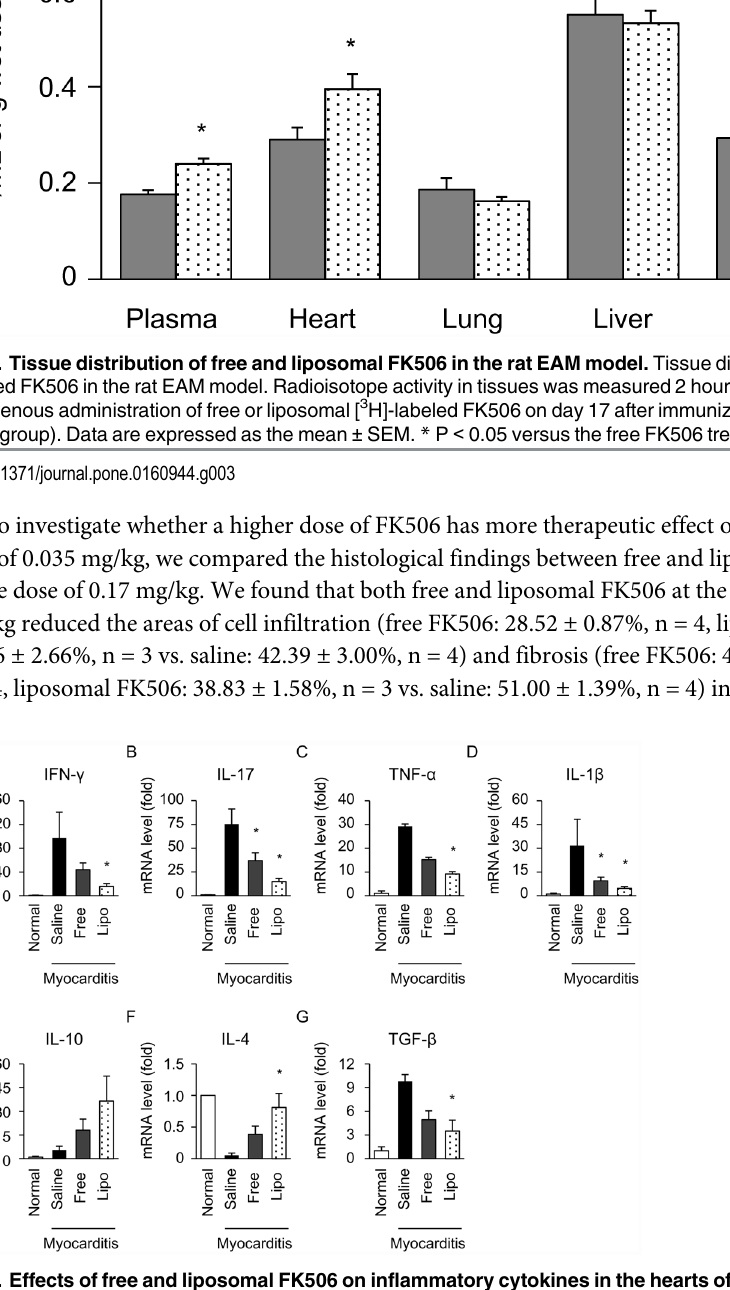
Fig 4. Effects of free and liposomal FK506 on inflammatory cytokines in the hearts of EAM rats. Cytokine expression on day 21 after immunization was evaluated using real-time quantitative PCR. Relative expression of IFN- γ (A), IL-17 (B), TNF- α (C), IL-1 β (D), IL-10 (E), IL-4 (F) and TGF- β (G) were normalized to GAPDH (N = 4 – 9 in each group). Data are expressed as the mean ± SEM. * P < 0.05 versus the saline treated